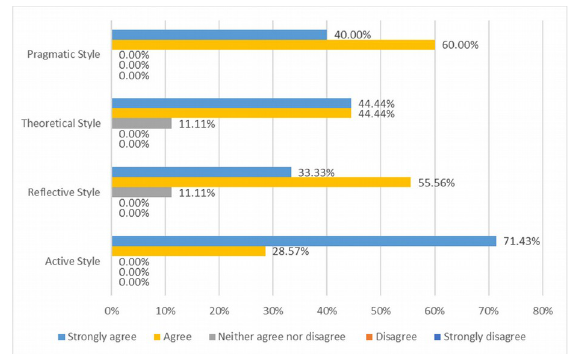
Figure 9. I am more likely to collaborate